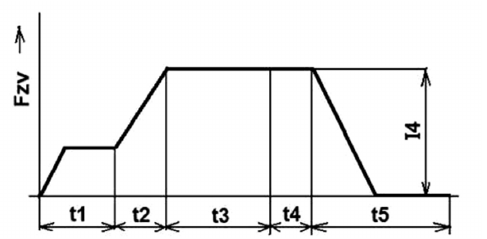
Figure 1: Welding cycle (Fzv – pressing force of electrodes, t – weld- ing time, I – welding current).